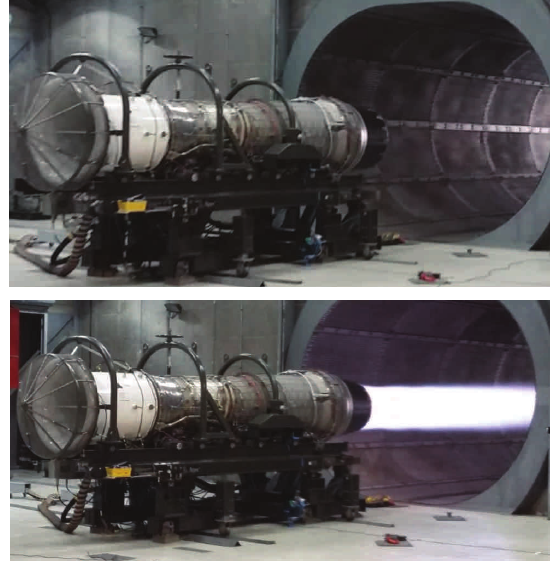
Fig. 1. View of the engine F100-PW-229 on the test stand